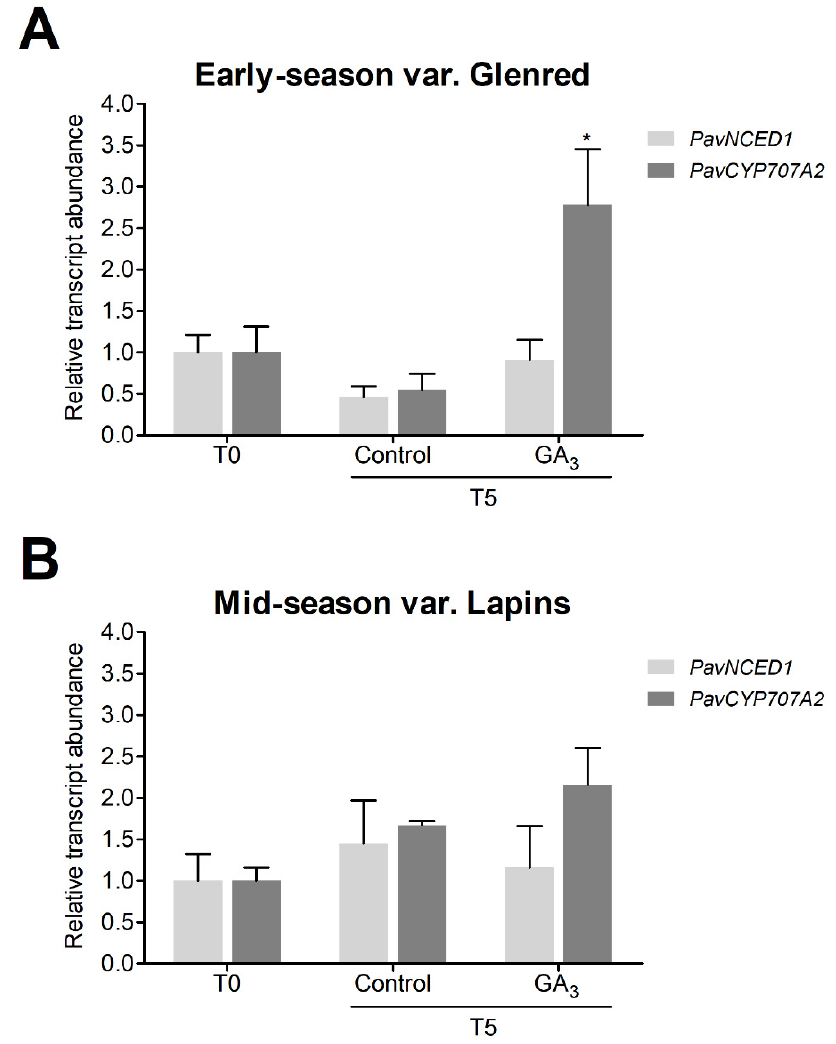
Figure 4. E ff ect of GA 3 on transcript abundance relative to PavCAC of PavNCED1 and PavCYP707A2 sweet cherry orthologs, 5 days after the treatment (T5). Fruits from control and GA 3 trees of ( A ) early-season variety Glenred and ( B ) mid-season variety Lapins, were randomly selected and pooled for the RT–qPCR analyses. Data as + SEM. Relative transcript abundance was set to 1.0 at T0, where T0 is the sampling performed immediately before GA 3 application ANOVA with Tukey’s post hoc test at p < 0.05 was conducted; “*” denotes statistical di ff erences between GA 3 -treated and control fruits for a